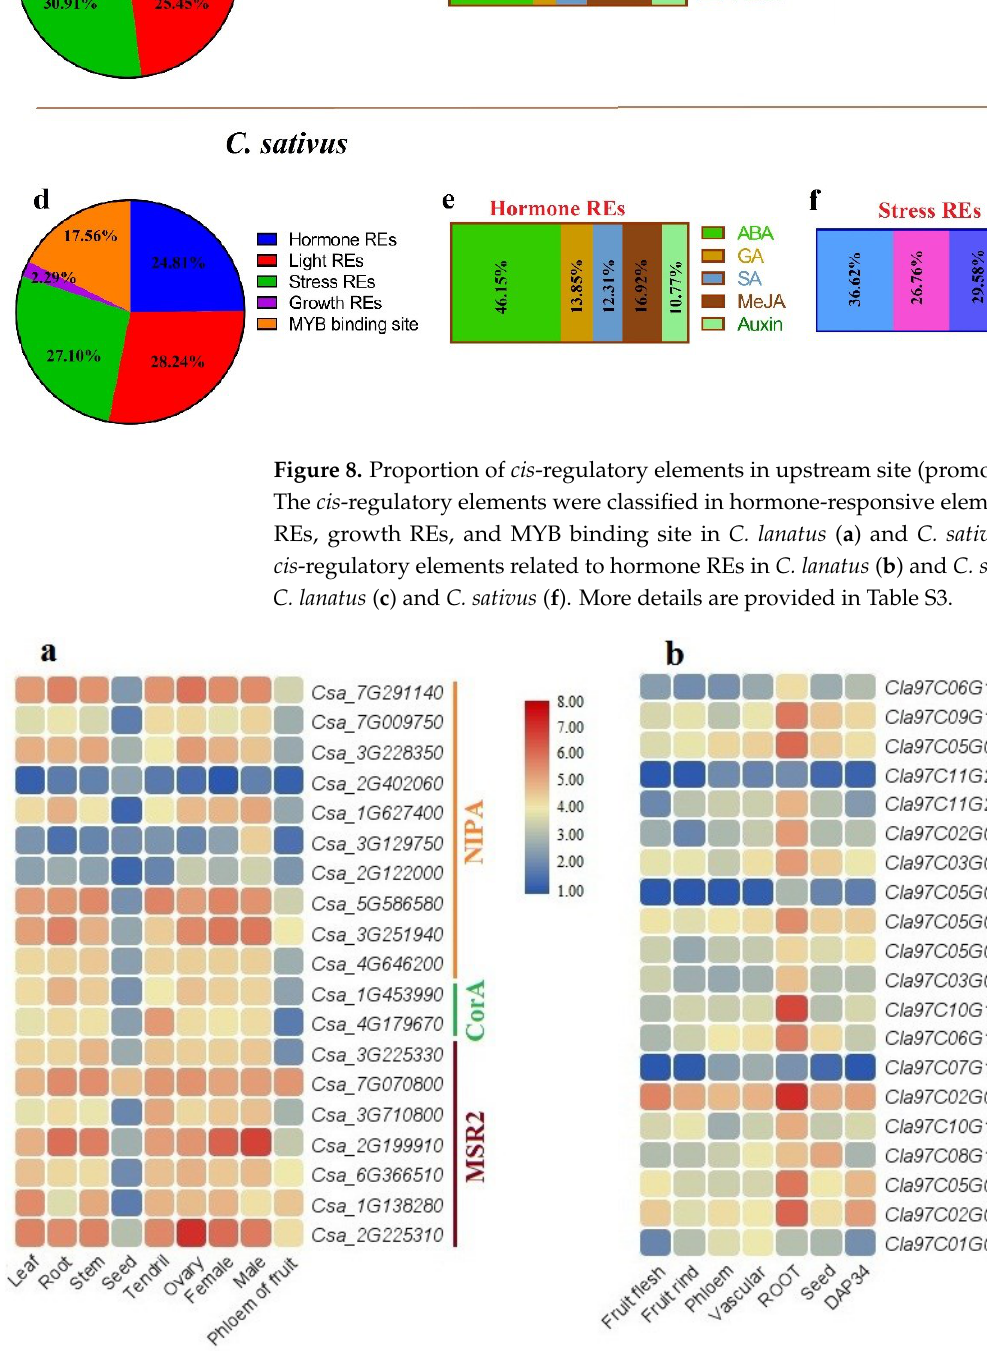
Figure 9. Heatmaps of expression of MGT genes in different tissues of C. lanatus ( a ) and C. sativus ( b ).